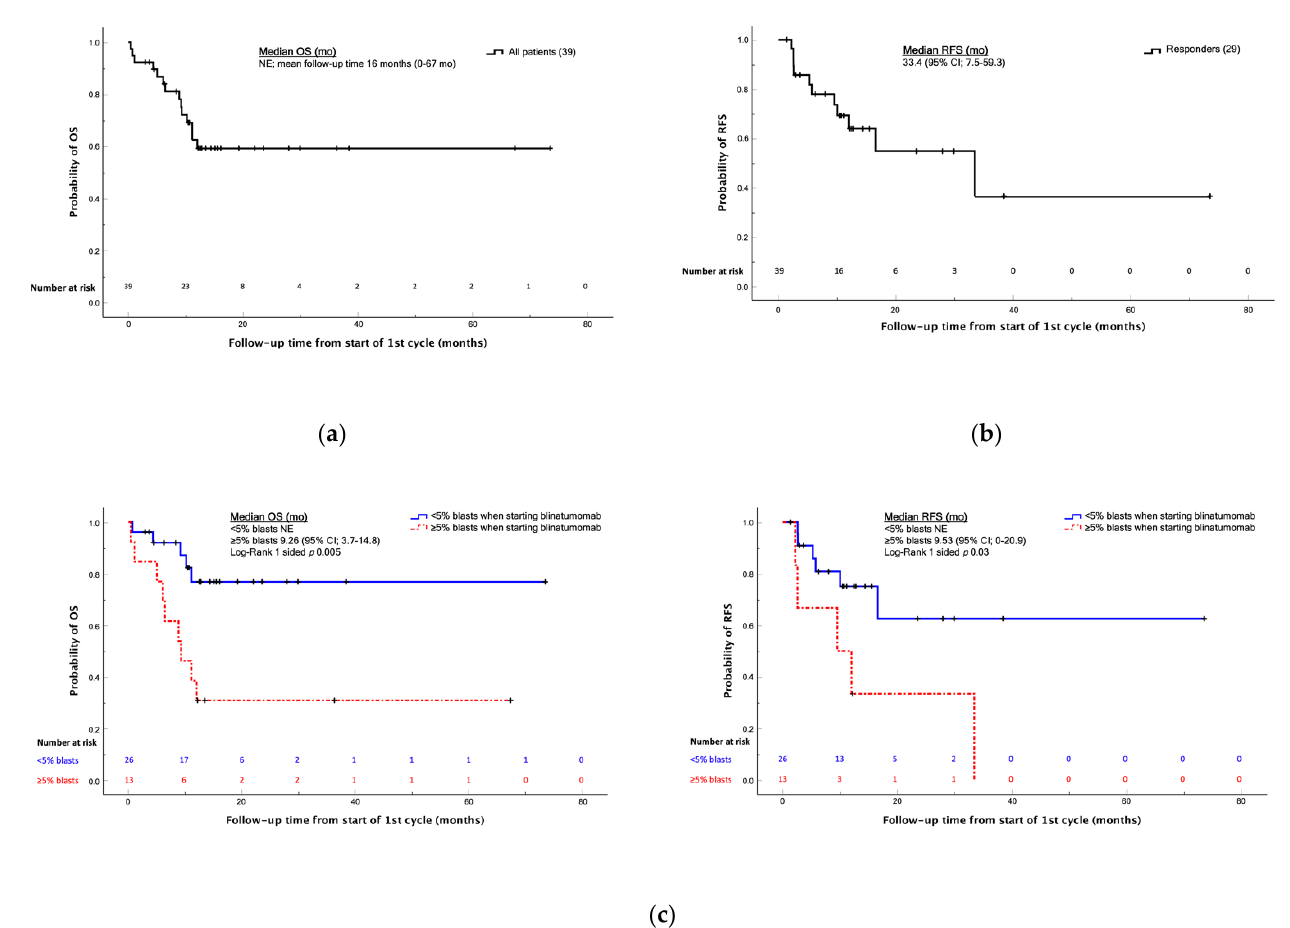
Figure 1. Kaplan-Meier analysis of the OS and EFS values in the cohort of patients between 2015 and 2020. ( a ) OS curve of the total cohort of 39 patients, median not evaluable over a mean follow-up of 16 months; ( b ) RFS curve of patients achieving remission, median 33.4 months; ( c ) OS and RFS curves of patients with <5% and ≥ 5% blasts at the time of blinatumomab administration. Abbreviations: OS, overall survival; RFS, relapse-free survival; mo, months; NE, not evaluable. As expected, OS was statistically better for patients who achieved a CR compared with those who did not ( p < 0.0001) (Figure